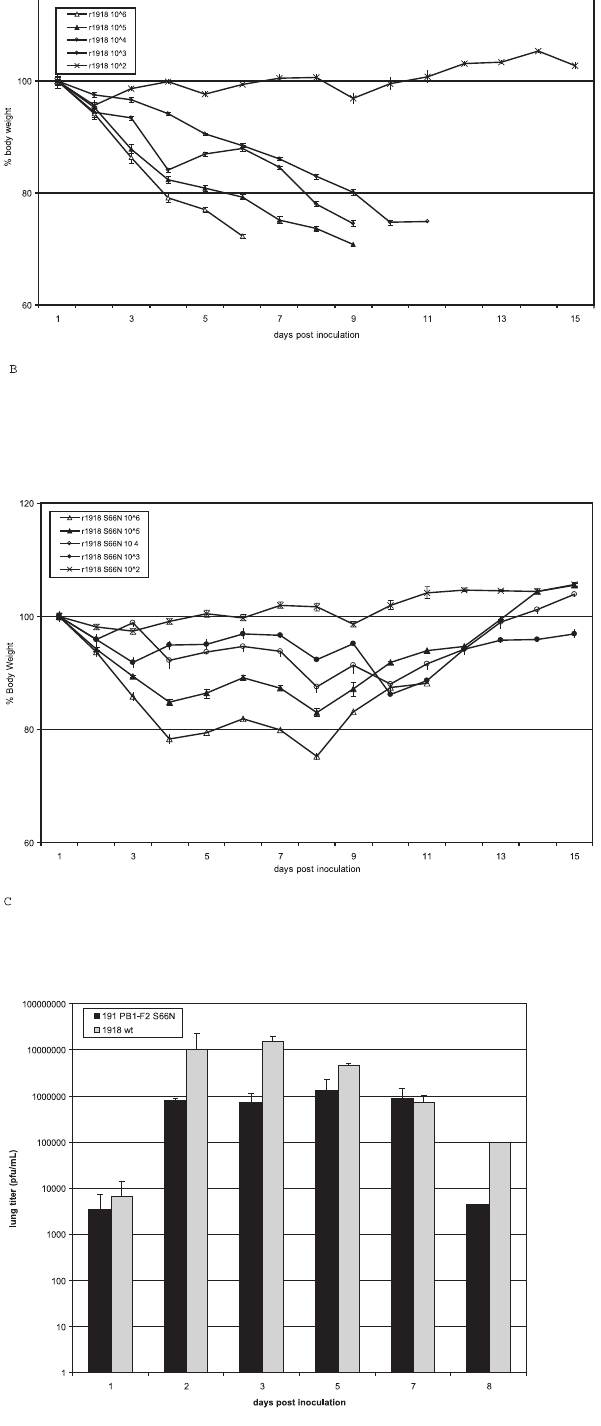
Figure 4. The Effect of the S66N Mutation on Pathogenicity in Mice (A) Eight mice were inoculated with recombinant wt 1918 virus at 10 2 , 10 3 , 10 4 , 10 5 , or 10 6 PFU, and their weights were measured every day. Average weights are represented in the graph. (B) Eight mice were inoculated with recombinant 1918 S66N virus at 10 2 ,10 3 , 10 4 , 10 5 , or 10 6 PFU, and their weights were measured every other day. Average weights are represented in the graph. (C) Effect of S66N mutation on mouse lung titers in r1918 virus.